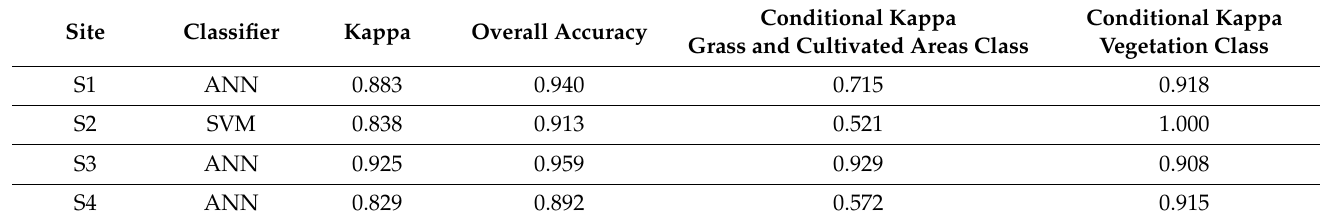
Figure 4. PlanetScope image classification with best validation results for the urban site. ( a ) Global view; ( b , c ) Classification and true-color composition of source image for Sub-area 1 (red rectangule in a); ( d , e ) Classification and true-color composition of source image for Sub-area 2; and ( f , g ) Classification and true-color composition of source image for Sub-area 3. Table 7. Summary of validation metrics for the classifications with best